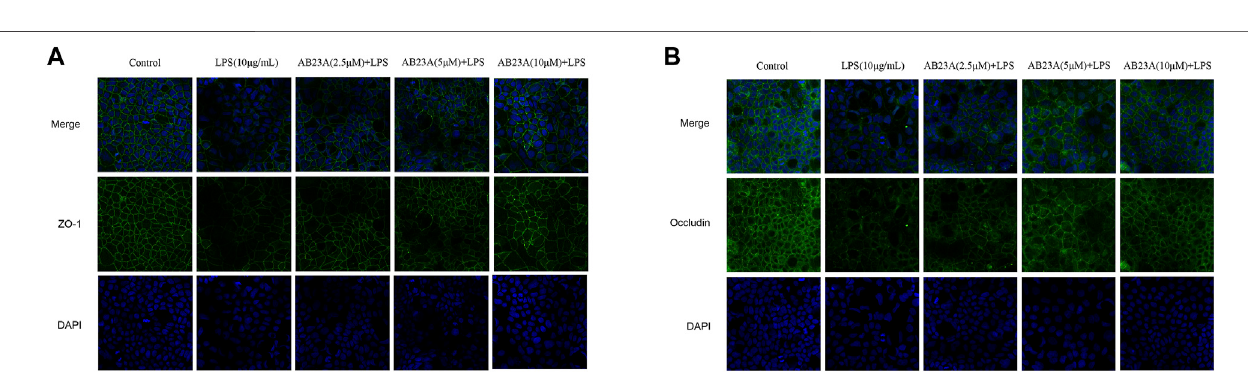
FIGURE 5 | AB23A effects on LPS-induced TJ structure and distribution in Caco-2 cells. Cells were cultured in the medium for several days before being treated with or without LPS (10 μ g/ml) and various concentrations of AB23A (2.5, 5 and 10 μ M) for 12 h. Immuno fl uorescence staining of (A) ZO-1 and (B) occludin. DAPI staining of the nuclei was utilized as a control image. Confocal laser scanning microscope was utilized to observe ZO-1and occludin protein localization in Caco-2 cells with or without LPS and AB23A (magni fi cation, ×20), respectively.